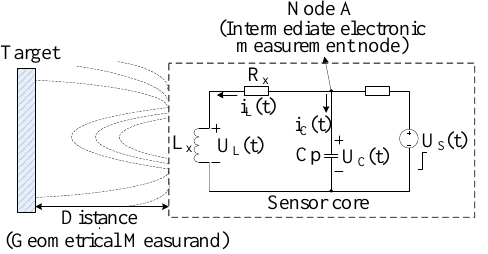
Figure 1. Block diagram of a classical IPS measurement circuit (the distance changes when the target travels between the target and the coil).